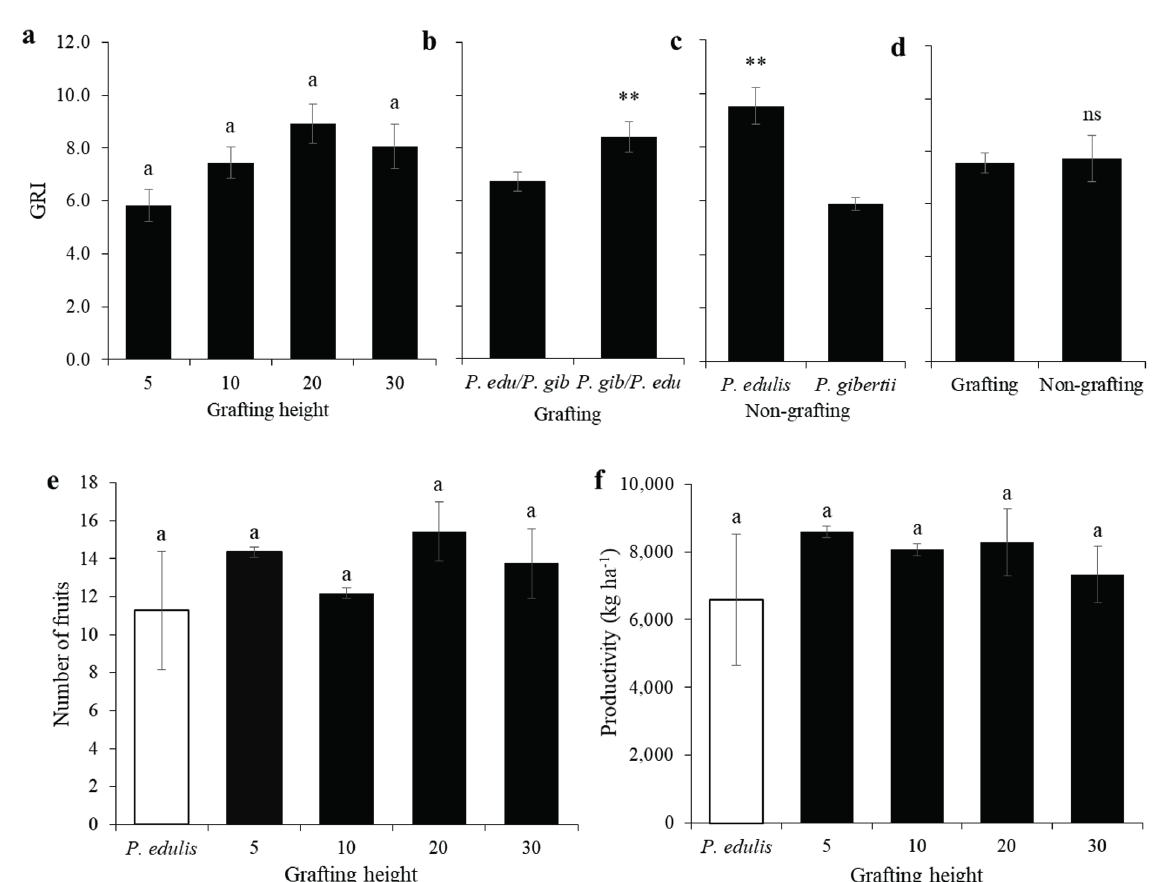
Figure 4 - Growth rate index (GRI) number of fruits per plant and productivity. ( a ) GRI at different grafting heights. ( b ) comparison of P. edulis grafted on P. gibertii and their reciprocal grafting. ( c ) comparison between non-grafted P. edulis and P. gibertii plants. ( d ) comparison between grafted and non-grafted plants in general under field conditions. ( e ) Number of fruits and ( f ) Productivity at different grafting heights. Error bar = standard error of the mean different letters indicate difference of the means by the Tukey test (p ≤ 005). **Indicates significant difference by the F-test (p ≤